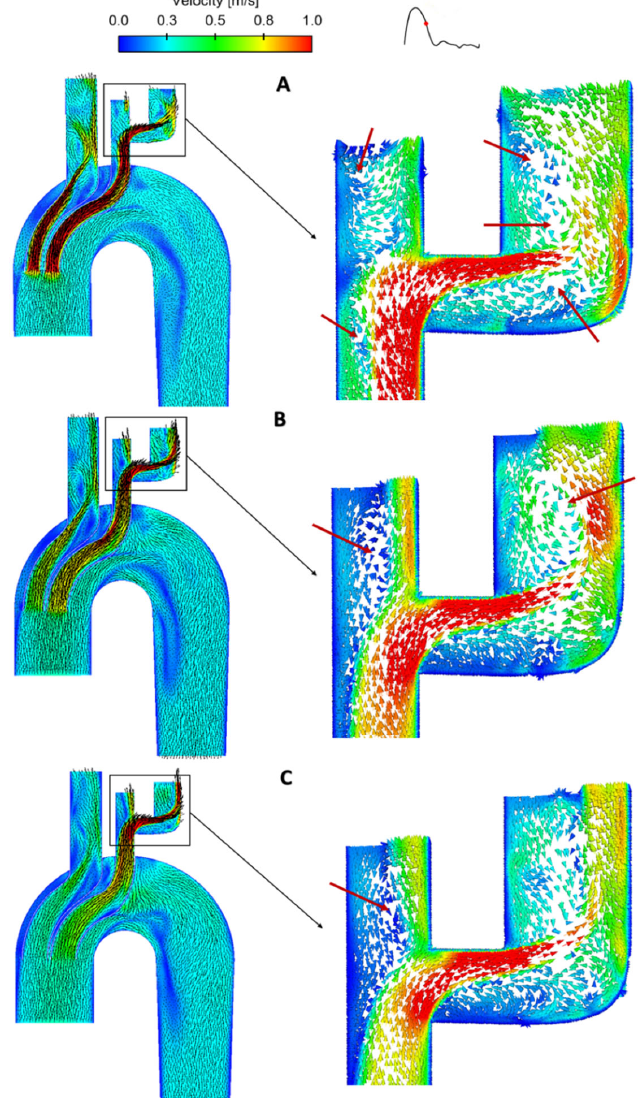
Figure 5. Comparison of velocity contours in the sagittal plane along with in ‐ plane velocity vectors between the three BSG models: ( A ) Stent ‐ graft 1, ( B ) Stent ‐ graft 2, and ( C ) Stent ‐ graft 3, at mid ‐ systolic deceleration (0.29 s). Detailed flow patterns are shown by local enlargement of the LCCA ‐ LSCA bypass (right column). FRZs in the bypass graft are indicated by red arrows.